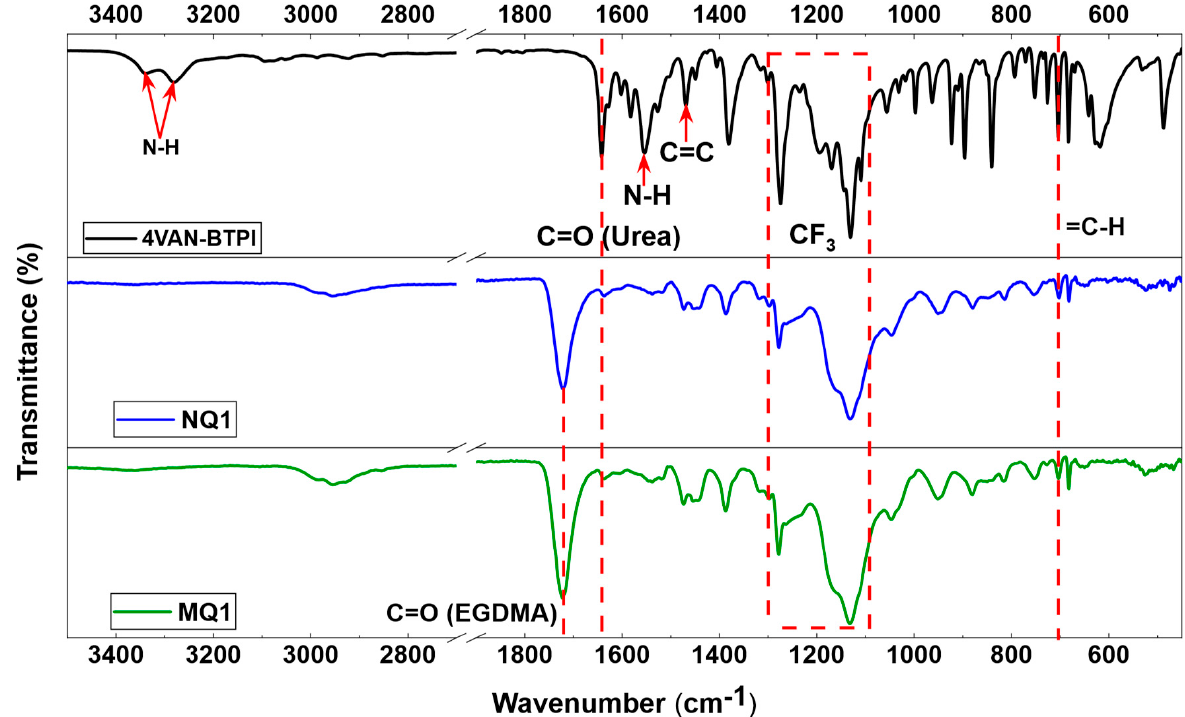
Figure 2. FTIR spectra of the 4VAN − BTPI monomer and its corresponding MIP and NIP.